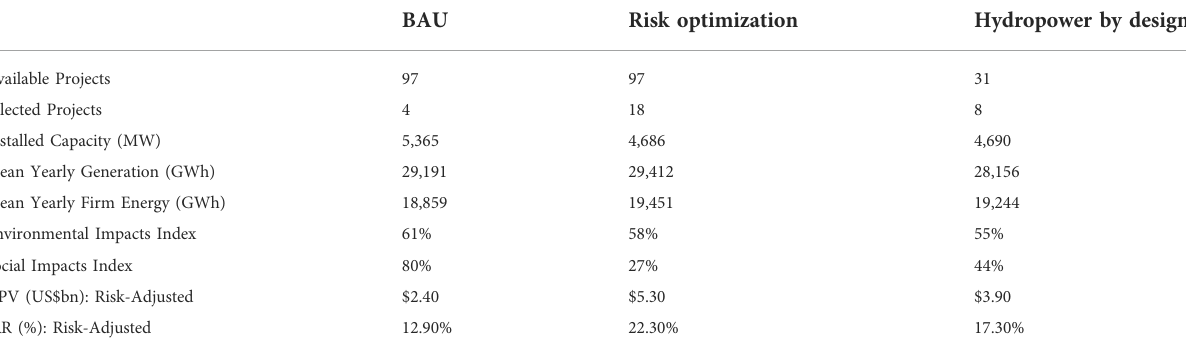
BAU Risk optimization Hydropower by